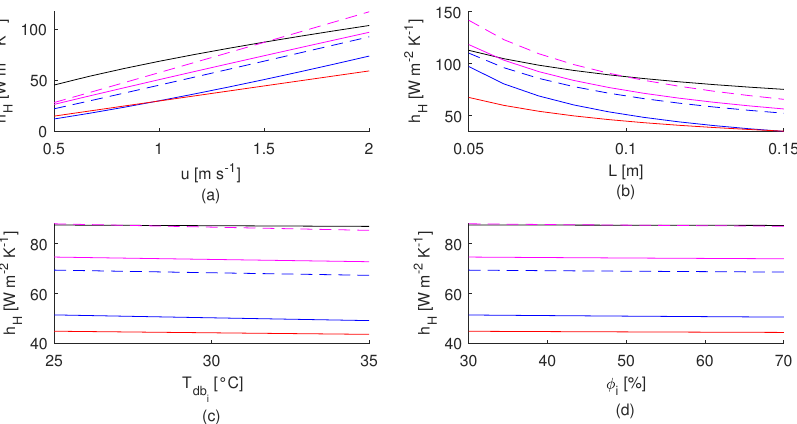
Figure 3. Comparison of the convective heat transfer coefficient ( h H ) for different pad materials and their dependency of the operative and constructive variables such as air velocity ( u ), pad thickness ( L ), dry-bulb temperature ( T db ) and relative humidity ( φ i ) of inlet air. ( a ) h H as a function of u . ( b ) h H i as a function of L . ( c ) h H as a function of T db . ( d ) h H as a function of φ i . For each plot the other i parameters remained constants: u = 1.5 m s − 1 , L = 0.1 m, T db = 30 ◦ C and φ i = 60%. CL pad: black i solid line, CS 1 pad: blue solid line, CS 2 pad: blue dashed line, BC pad: red solid line, PS 1 pad: magenta solid line, PS 2 pad: magenta dashed